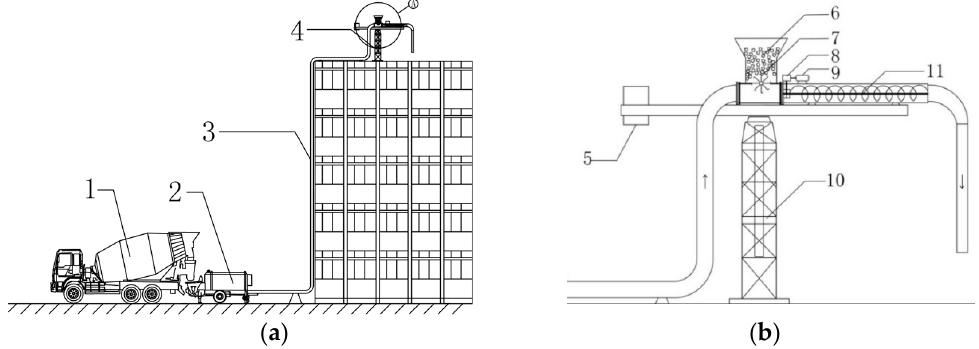
Figure 1. Schematic diagram of construction technology for post-filling coarse aggregate concrete. (1) Concrete truck, (2) delivery pump for concrete, (3) conveying line for concrete, (4) distribution spreader, (5) balancing weight for distribution spreader, (6) coarse aggregate storage silo, (7) turbine, (8) speed reducer, (9) motor, (10) support for coarse aggregate distribution spreader, (11) spiral conveyor device. ( a ) Construction technology for post-filling coarse aggregate concrete. ( b ) Zoom in view of “A”.